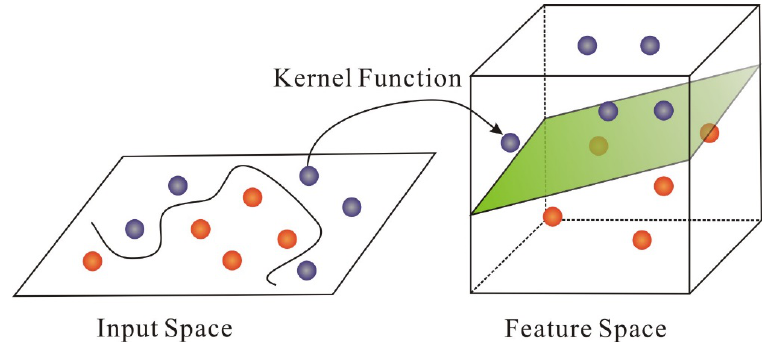
Figure 15. The key process of Support vector machine [63].